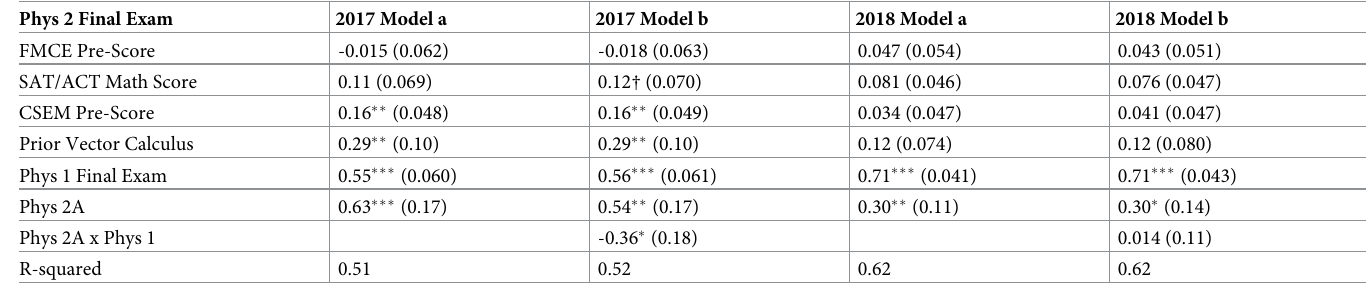
Table 4. Regression models for Phys 2 final exam performance including Phys 1 final exam as a predictor. Coefficients are in units of standard deviations and the numbers in parentheses are the standard